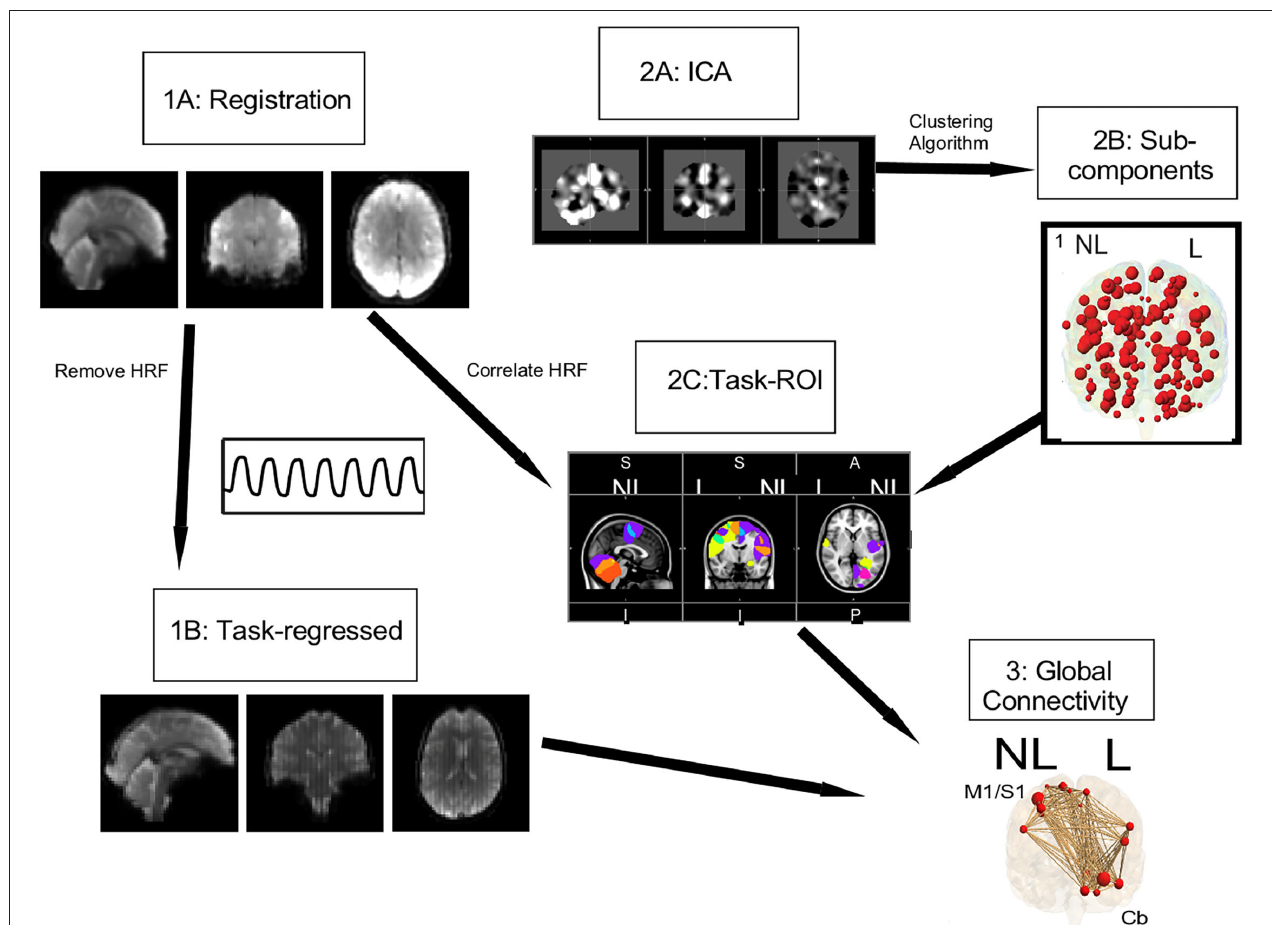
FIGURE 3 | Connectivity pipeline. Registration (1A) and task regression (1B) were performed on the data collected for this study. Using the Smith et al. (44) data, an ICA (2A) and a clustering algorithm were performed to get 149 subcomponents, shown in red circles (2B). From these 149 subcomponents, task ROI (2C) were defined by correlating the HRF with the mean timeseries of our study’s data. For these task ROI, shown with red circles the global connectivity (3) strength, shown with brown lines, was